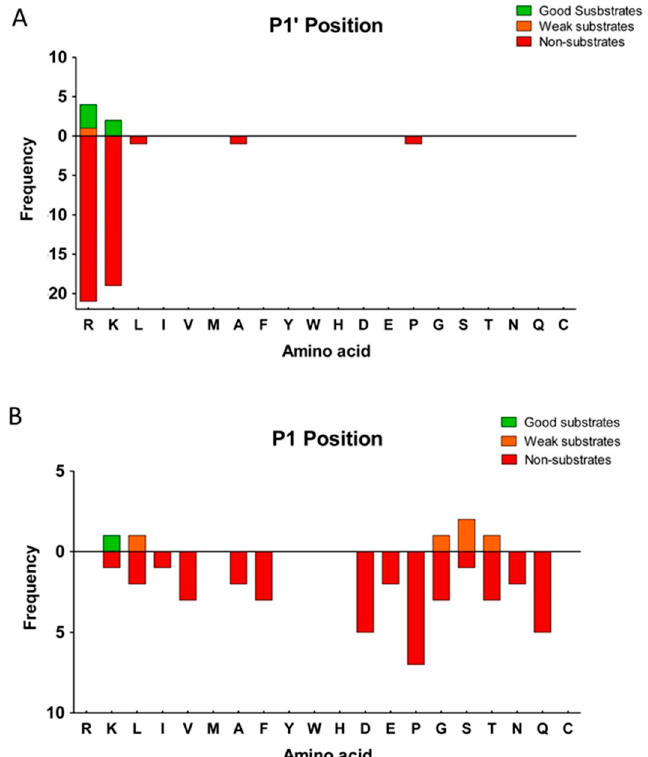
Figure 6. Analysis of the substrate preferences of CPZ determined using the tryptic peptide library. Substrate preferences of CPZ at ( A ) C-terminal (P1 ′ ) and ( B ) penultimate (P1) positions. The frequency for each amino acid present in P1 or P1 ′ is indicated for good substrates, weak substrates, and non-substrates. For P1 analysis, only substrates with permissive P1 ′ amino acids according to the results from ( A ) were considered.